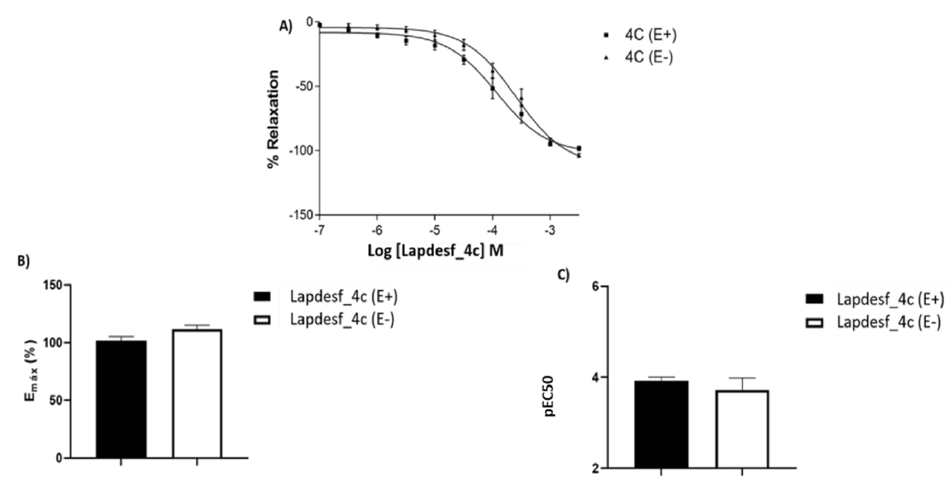
Figure 2. ( A ) Concentration–effect curves after treatment with Lapdesf-4c in the absence (E − ) and presence of the endothelium (E+). ( B ) shows the Emax values expressed in percentage for Lapdesf-4c in the absence (E − ) and presence of aortic intact endothelium (E+). ( C ) expresses the pEC50 values in the absence (E − ) and presence of the endothelium (E+). Each experiment was performed on rings prepared from different rats.